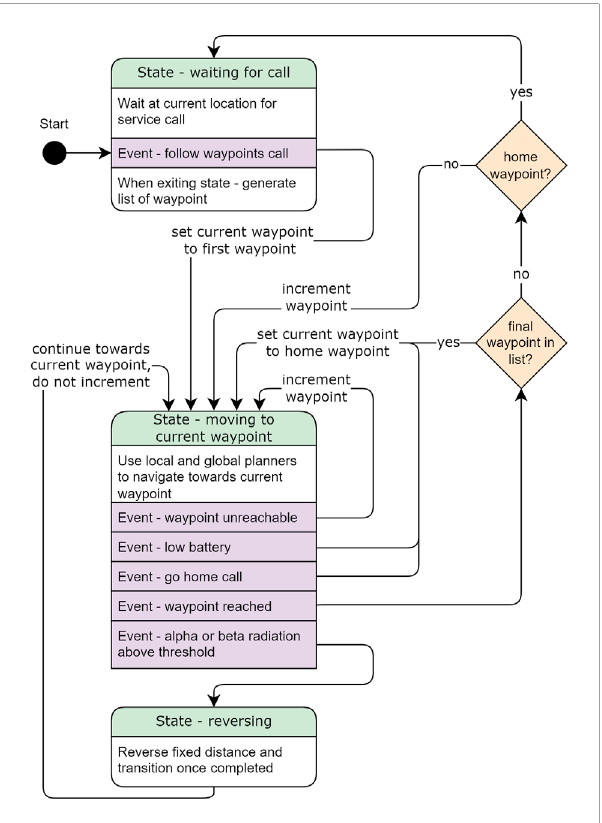
FIGURE 6 Flow diagram showing the operation of the state machine that controls the navigation of CARMA II. The three states are represented by the rounded boxes with state names highlighted in green, events that trigger transitions are highlighted in purple, transitions are represented by the black arrows and decisions during transition are represented by the